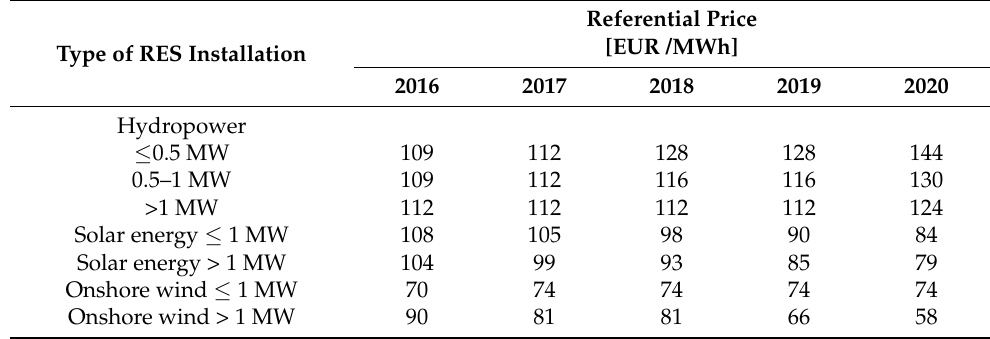
Table 7. Selected referential prices of the electric energy originating from the RES in